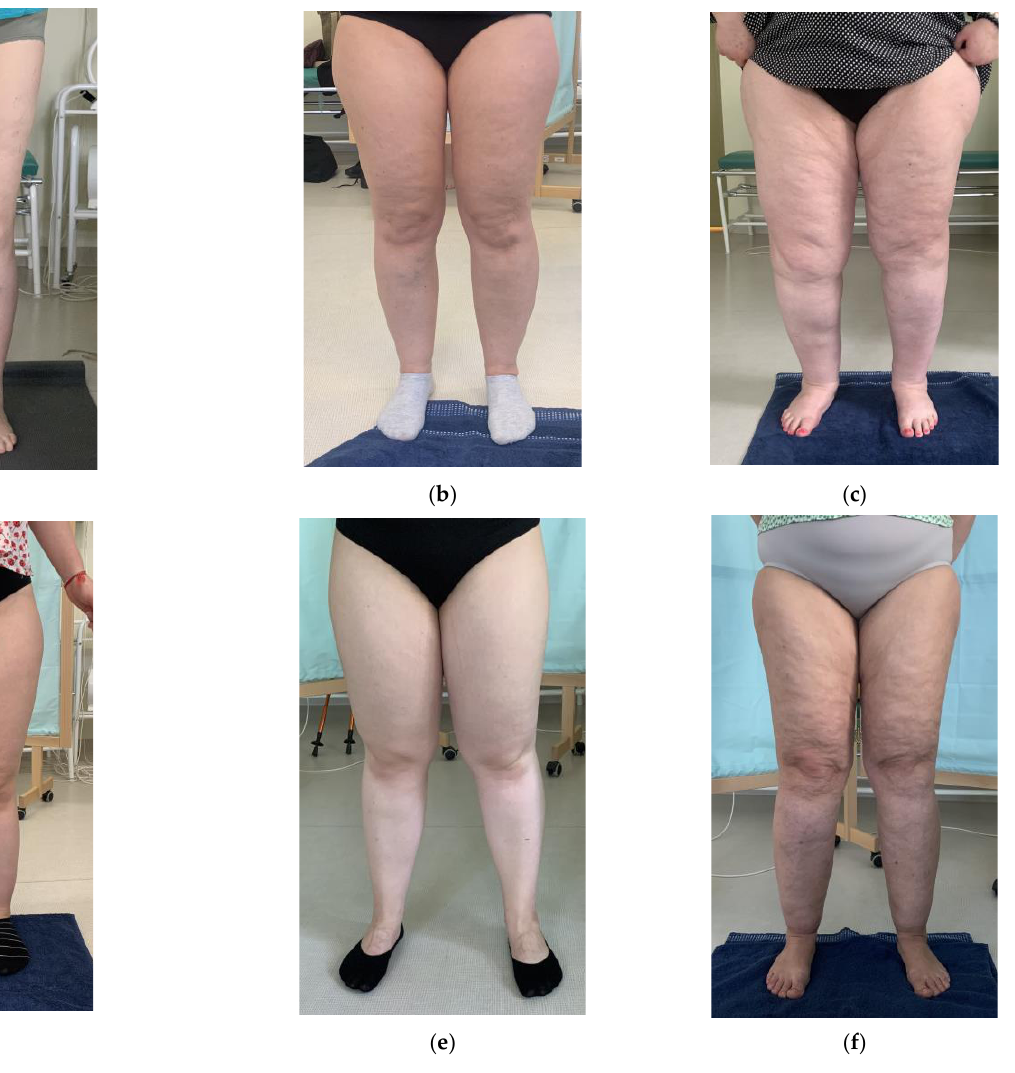
Figure 2. Lipedema patients from group A ( a – c ) and from group B ( d – f ). Table 1. Characteristics of participants in groups A and B. Changes in circumference were not significant; however, even a slight reduction or maintaining the same value is perceived as beneficial. The results show that, in group A the total growth of circumference of the thigh at 2/3 length from knee to buttock (P8) comparing 6 weeks to baseline, was 4 cm on one side, while in group B, a total decrease of 1 cm could be observed. The measurement P11 (calf at 2/3 length from the ground to the knee) in the group that underwent compression therapy did not change during the whole study, while in the group without compression, there was an increase of 0.5 cm on each side in patient 1, and patient 2 experienced an increase by 1 cm on the right side, and patient 3 had +1 cm on the left side after 6 weeks compared to baseline. The circumference of the calf at 1/3 length from the ground to the knee (P12) was reduced by 2 cm on each side in patient 3 from the group with compression after 4 weeks; however, after 6 weeks, it increased by 1 cm on the right and 0.5 cm on the left side. The remaining two patients from group B did not experience significant change comparing circumference at the beginning to the end of the study. In group A, measurement P12 did not change in patient 1; patient 2 experienced an increase of 2 cm on each side, and patient 3 had a decrease of 1 cm on the right and an increase of 1 cm on the left side. Circumference P13 (foot circumference at the level of the metatarsal heads) did not change in any of the patients, which confirms the statement that feet are not affected by